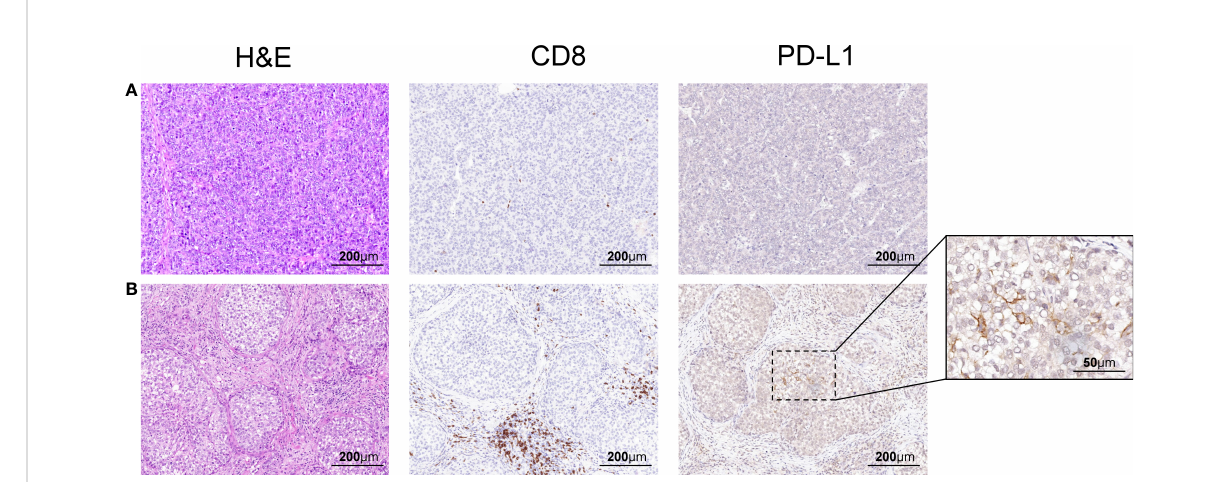
FIGURE 2 Representative pathological sections of primary and recurrent tumors. (A) In the primary tumor in the liver, H&E staining and IHC showed in fi ltration of a few CD8-positive T cells and negative PD-L1 expression. (B) In the remaining tumor in the lung after sintilimab treatment, H&E staining and IHC showed in fi ltration of CD8-positive T cells in the mesenchymal area but not in the tumor and focal PD-L1